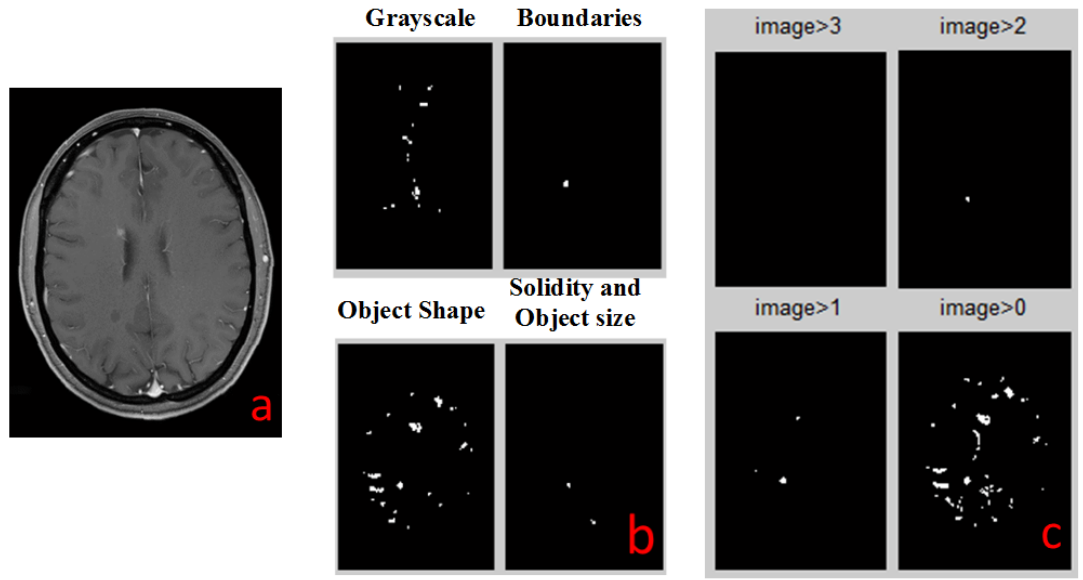
Figure 4. MS detection for image with T1_FL2D with IV contrast type: ( a ) original Image; ( b ) results of all detection algorithms; ( c ) combination of all detection results, displaying pixels with value greater than a threshold value (see titles). The value of each pixel denotes the number of algorithms (out of 4) that detected this pixel as part of a positive suspected MS lesion.